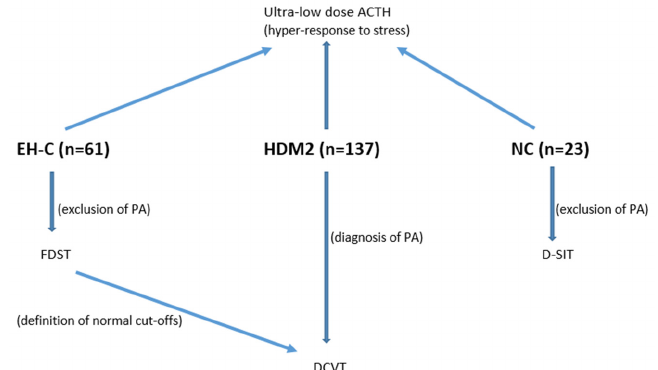
Figure 1. Graphical explanation of the study design. EH-C: non-diabetic patients with essential hypertension; HDM2: hypertensive patients with DM2; NC: normotensive/normoglycemic healthy individuals; FDST: fludrocortisone–dexamethasone saline-loading test; DCVT: dexamethasone–captopril–valsartan test; D-SIT: dexamethasone-saline infusion test.